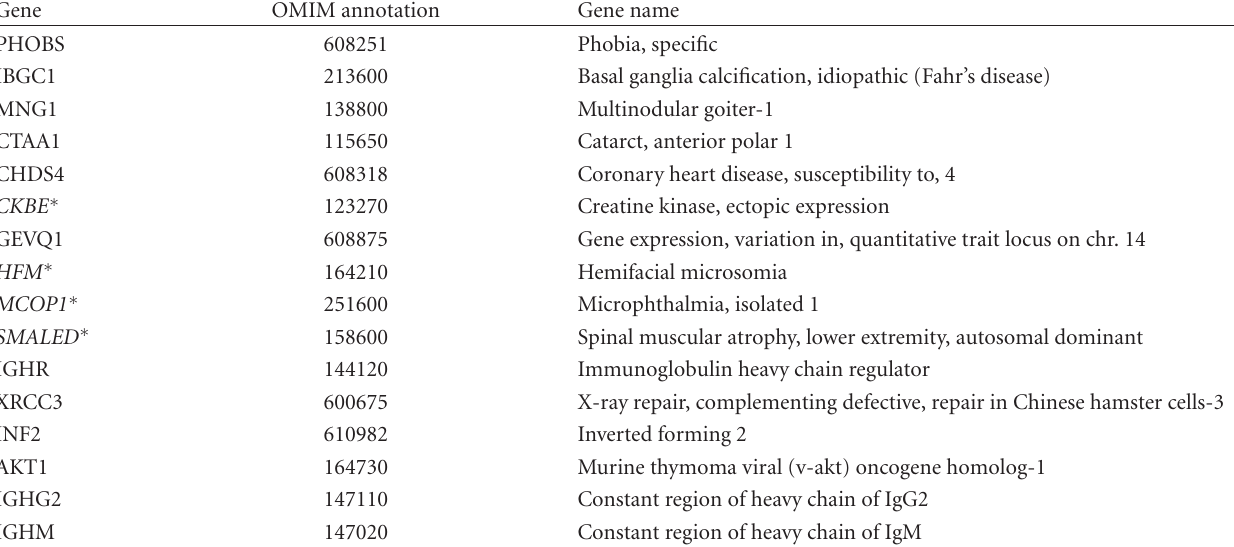
Table 2: A list of the 16 genes deleted with a known phenotype on chromosome 14 with the Online Mendelian Inheritance of Man (OMIM) annotation. We believe that CKBE, HFM, MCOP1, and SMALED (noted by asterisk) may be significant in the previously described 14q32 deletion